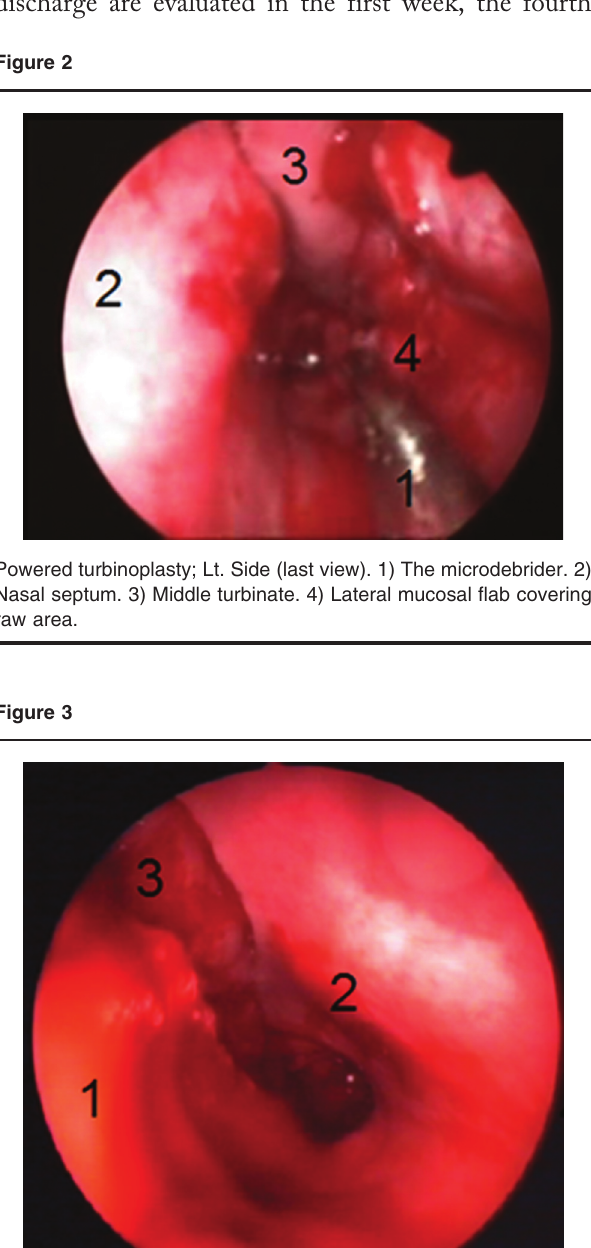
Powered turbinoplasty; Lt. Side. 1) The microdebrider. 2) The lateral mucosal flab.3) Nasal septum. Submucosallayerandbony turbinate.